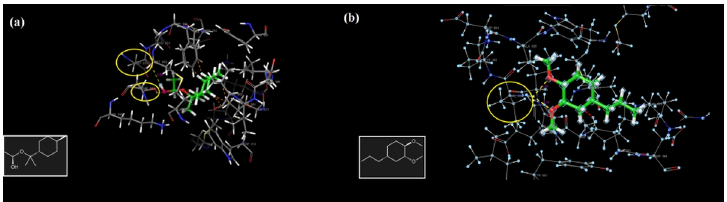
Figure 2. The photoexcited charge flow path in ( a ) type-II and ( b ) type-II band alignment of the Figure 10. The hydrogen bonding interactions of methyleugenol with Val 882 ( a ), and α -terpinyl MoTe 2 /PtS 2 vdWH. acetate with Asp 950 ( b ) in the PI3K/mTOR target receptor.